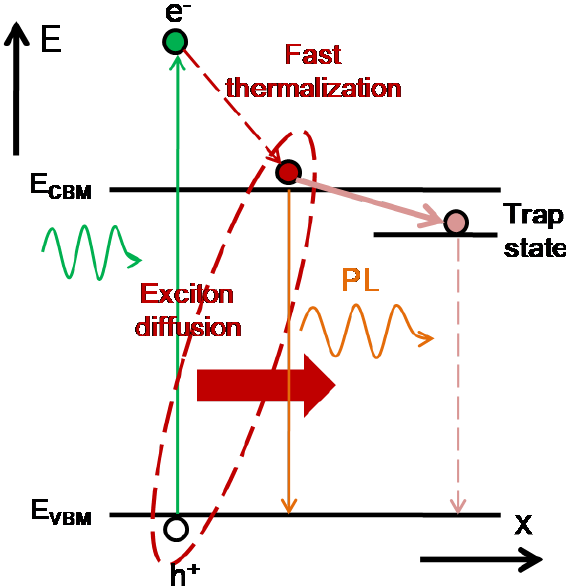
Figure 1. Photo-excited carrier dynamics in an energy–space diagram.